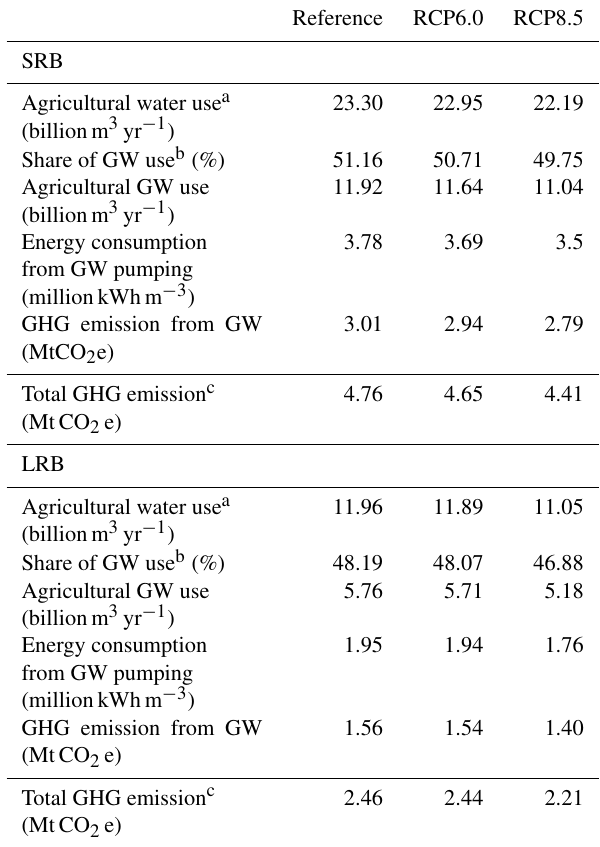
Table 8. Total GHG emission from irrigation in the SRB and LRB in